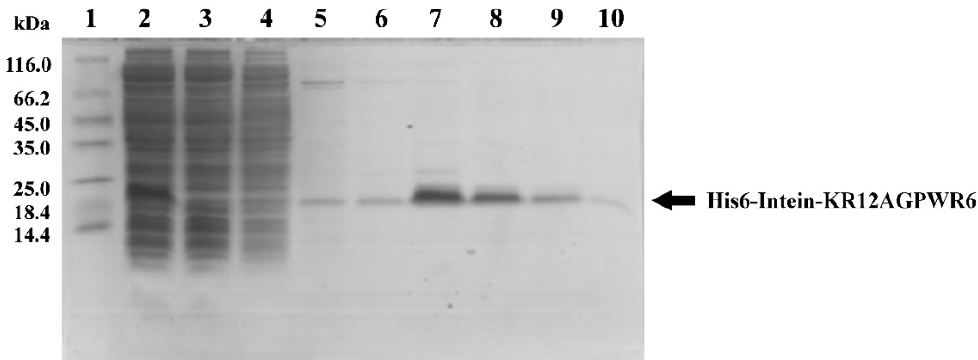
Figure 3. SDS-PAGE analysis of recombinant His6-Intein-KR12AGPWR6 expressed in E. coli at different steps of purification procedure. Lane 1: protein molecular weight markers (kDa); lane 2: supernatant of cell lysate; lane 3: flow through; lane 4–6: washing by 40 mM imidazole; lane 7–10: elution by 400 mM imidazole. Proteins were visualized using Coomassie blue staining.